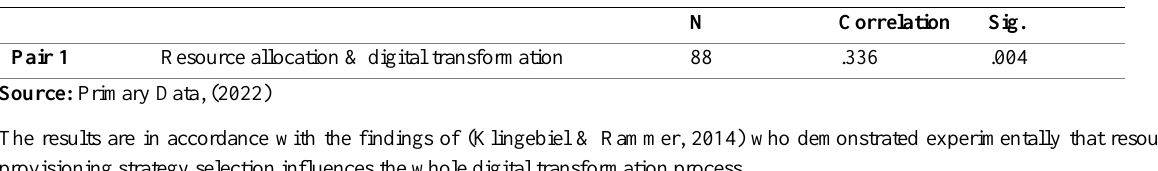
Table 2: Resource Allocation & Digital